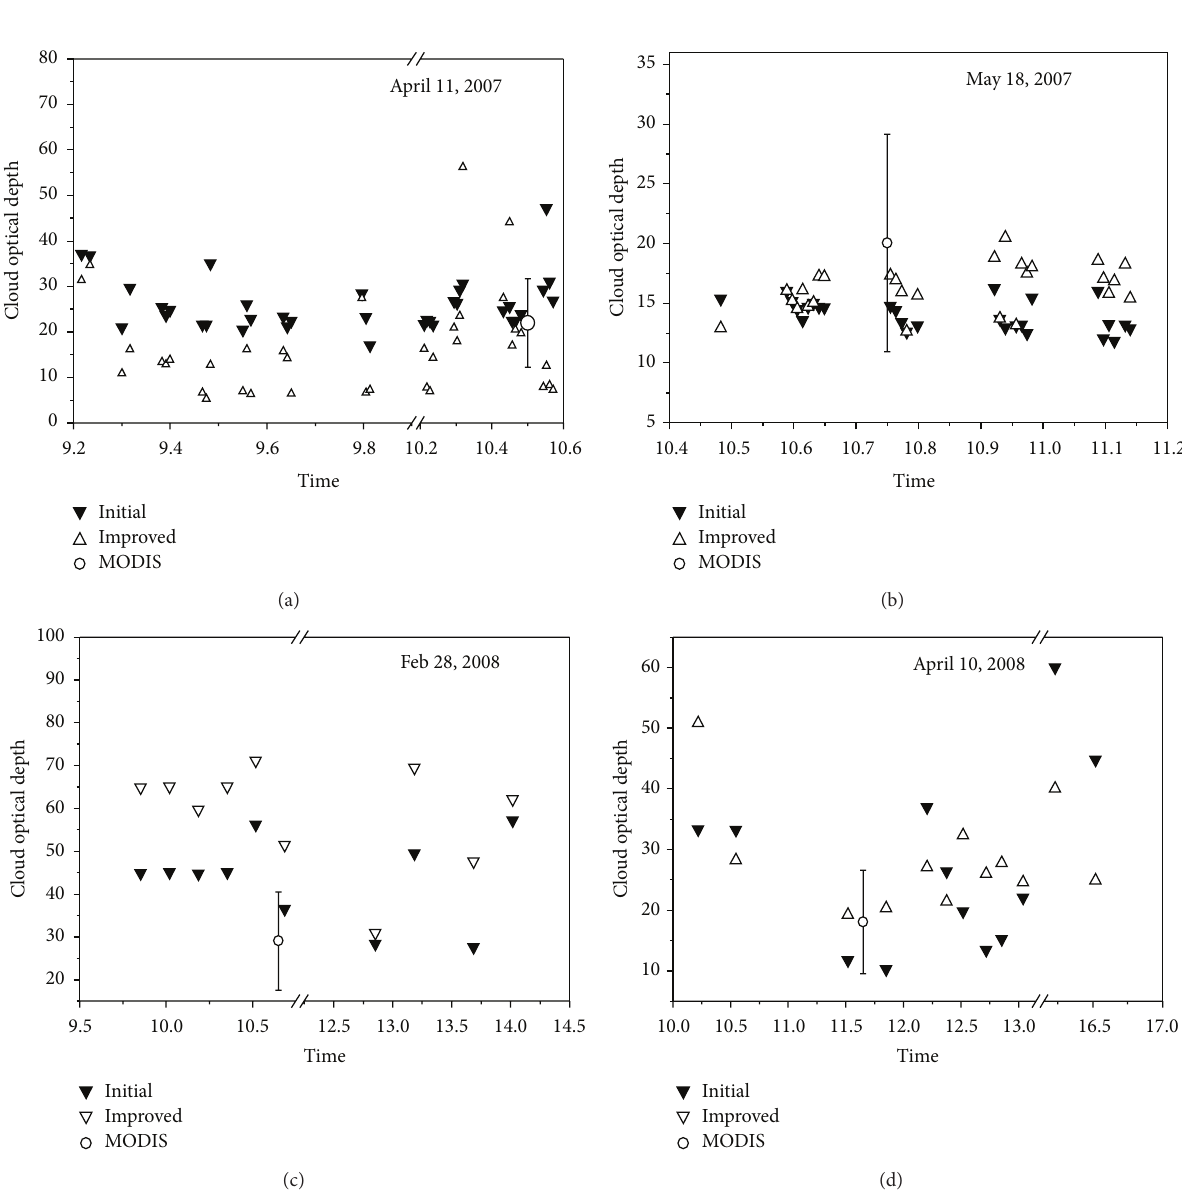
Figure 8: Initial, improved and satellite derived cloud optical depth for Chiba (11 April and 18 May, 2007) and cape Hedo (28 February and 10 April,